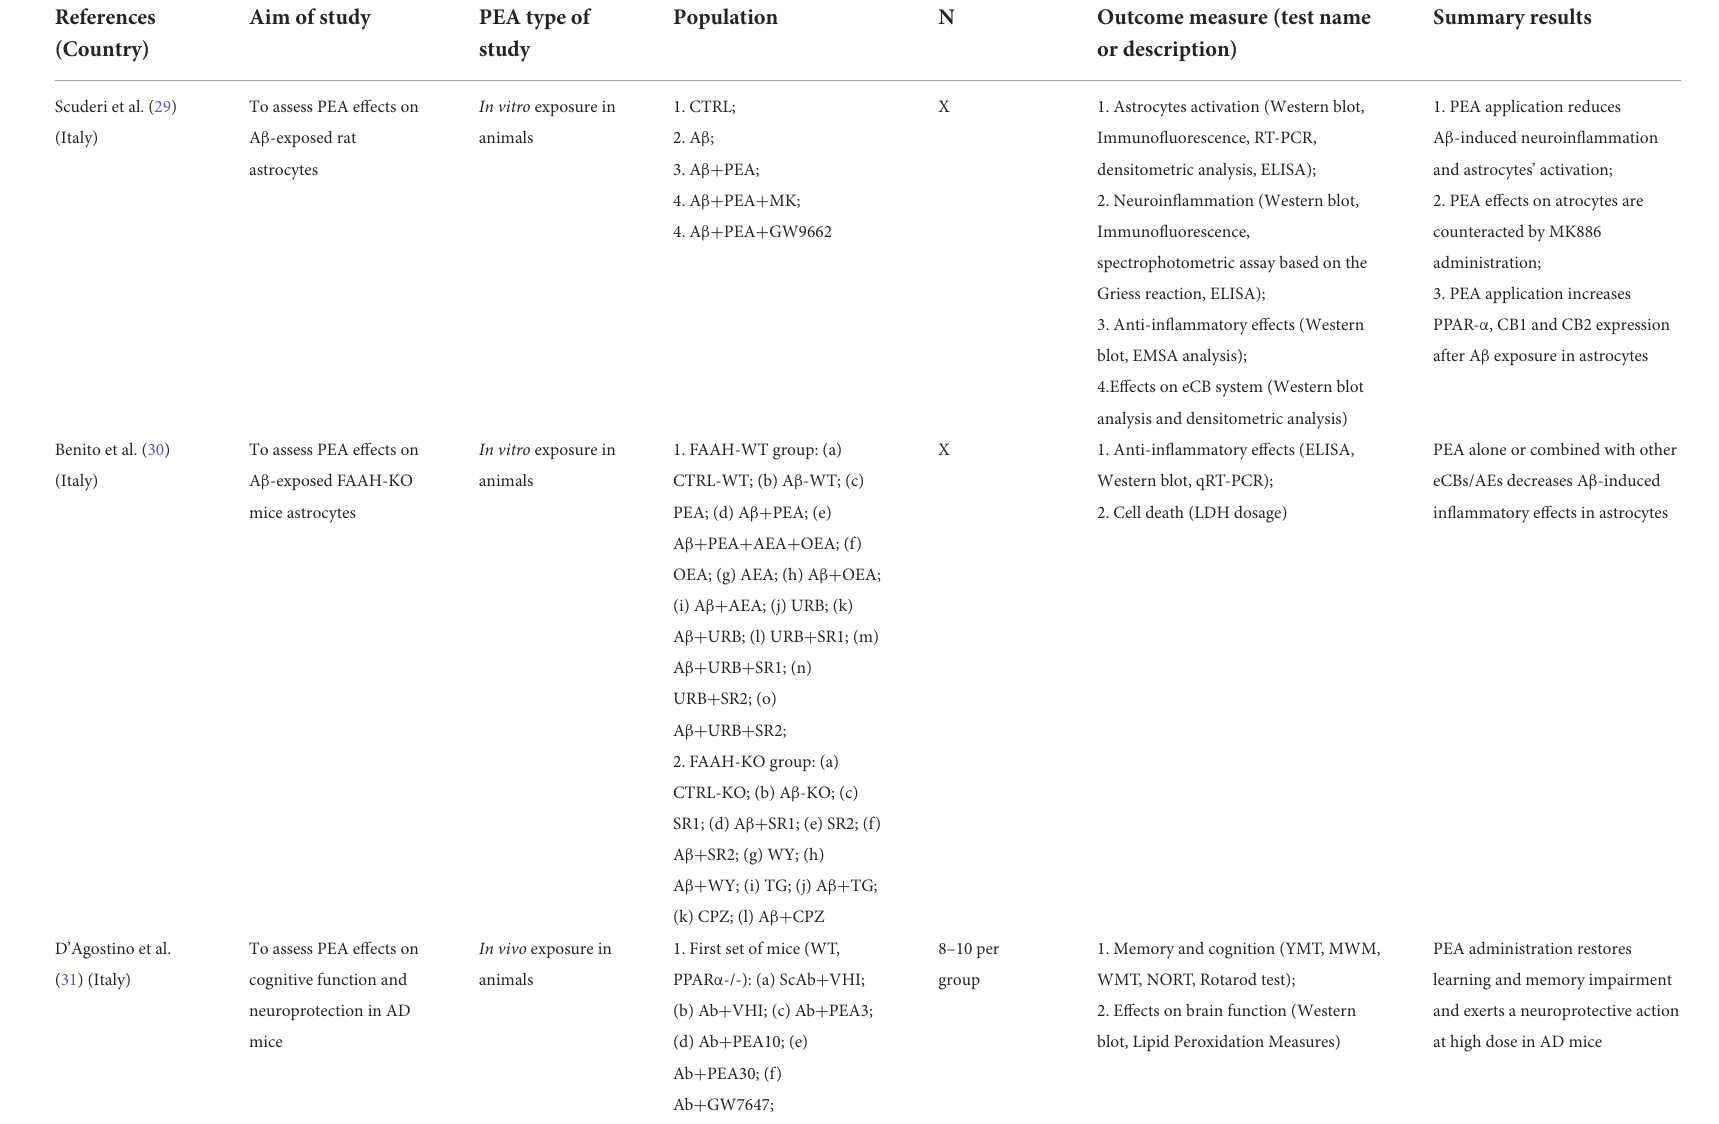
TABLE 1B Summary of preclinical studies investigating palmitoylethanolamide and its correlations to neurocognitive disorders